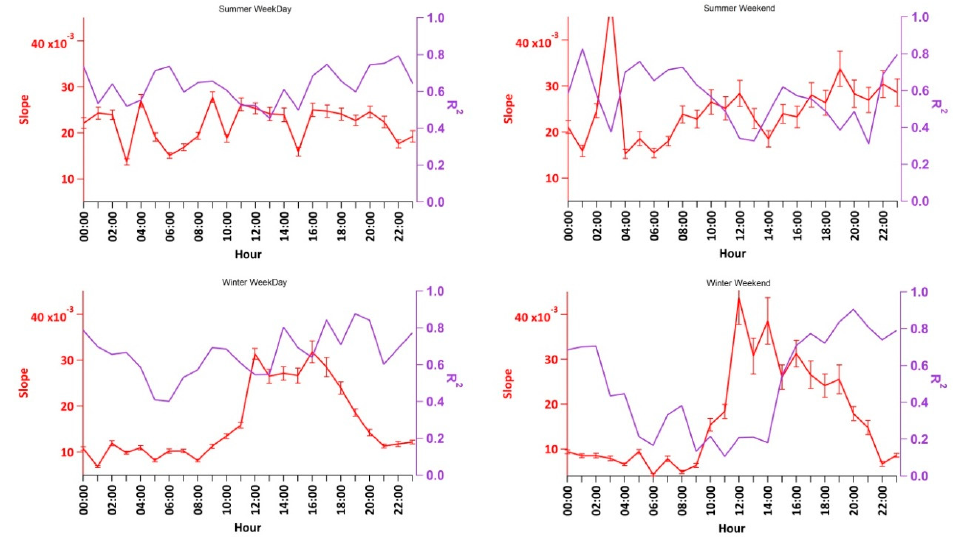
Figure 6. The Slope and r 2 value from the regression (WODR) between NH 3 and CO varied with the hour ‐ of ‐ day, for weekdays and weekends during summer (top panel) and winter (lower panel).